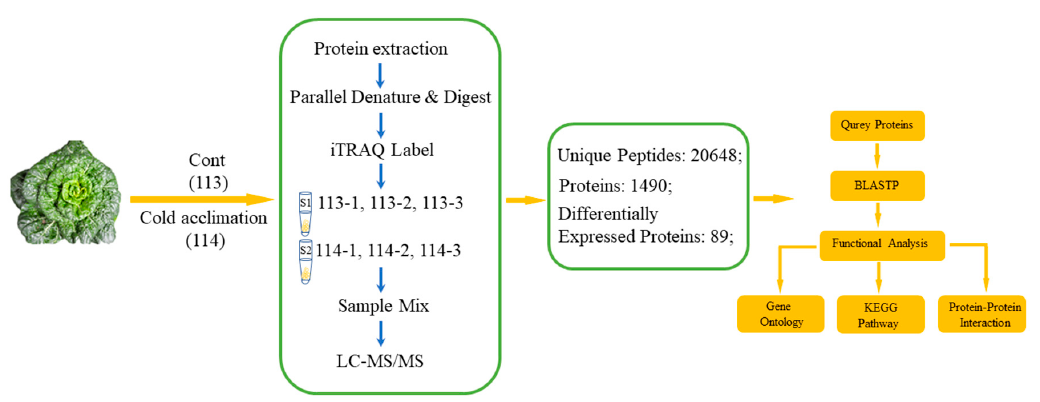
Figure 1. Schematic diagram for the identification of differentially expressed proteins via the isobaric tags for relative and absolute quantification (iTRAQ) method.